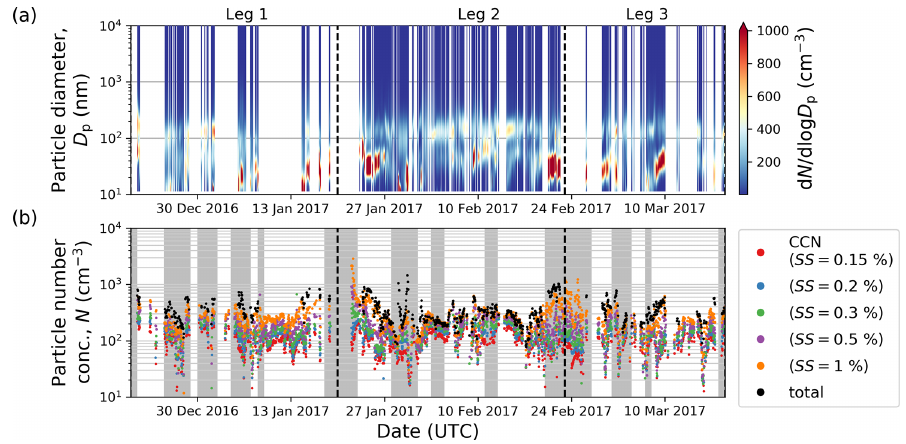
Figure 2. Time series of (a) hourly smoothed PNSD and (b) total aerosol particle (black) and CCN number concentration (colour-coded by supersaturation) during Legs 1–3. Ports visited (dashed lines) and vicinity to land (grey area) are indicated in the figure. Data gaps stem from filtering for instrument availability and exclusion of stack exhaust contamination periods. In (a) the Hoppel minimum can be seen as local minimum in the Aitken mode of the PNSD (Leg 1: 48nm, Leg 2: 74nm, Leg 3: 68nm on